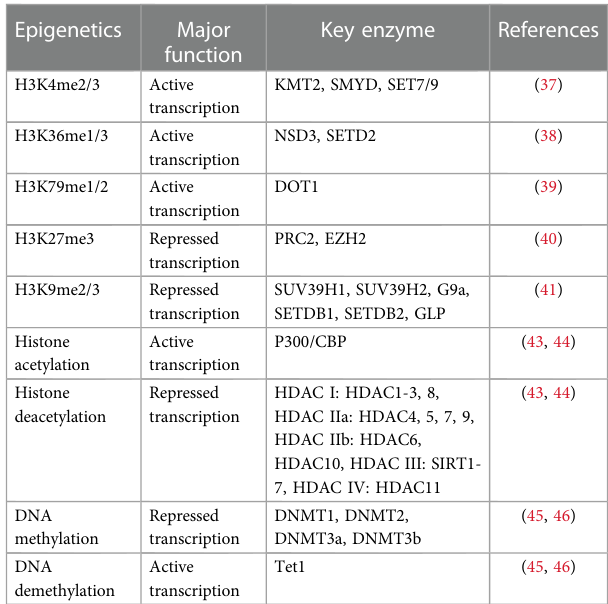
TABLE 1 Histone modi fi cation and DNA methylation in epigenetics associated with